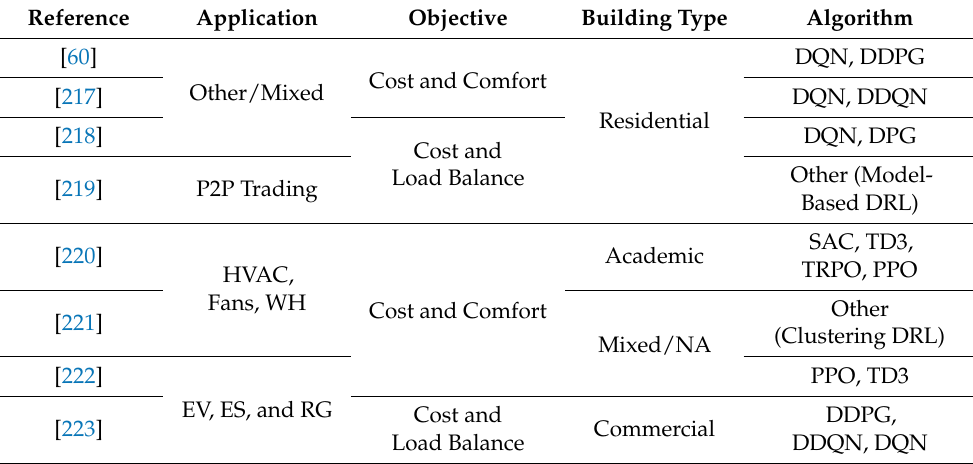
Table 5. References using Combination of Methods and/or Miscellaneous